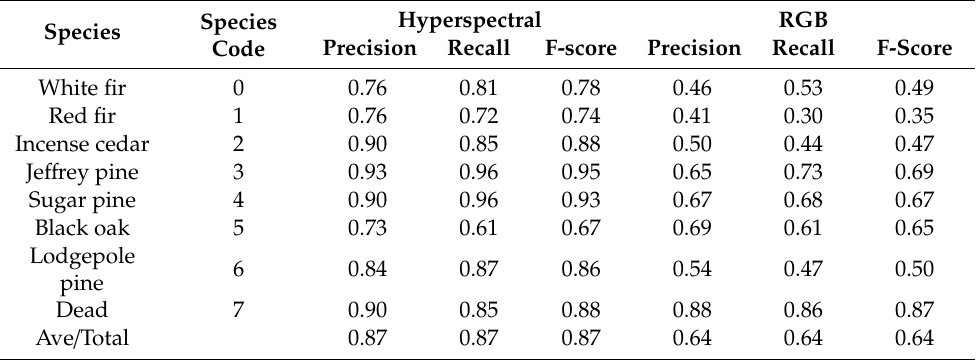
Table 2. Summary results table reporting the precision, recall and F-Score for the average of 10 folds of the k-fold cross validation for both the Red-Green-Blue subset and hyperspectral imagery. Hyperspectral RGB Species Species Precision Recall F-score Precision Recall F-Score Code White fir